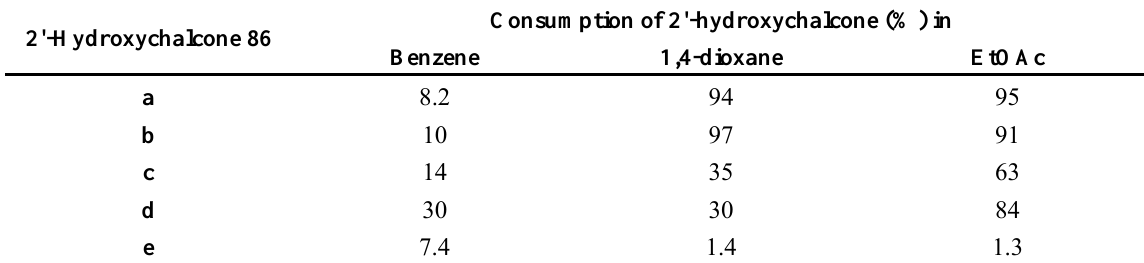
Table 8. Effect of the solvent on the relative rates of photochemical flavanone formation from 2'-hydroxychalcones.